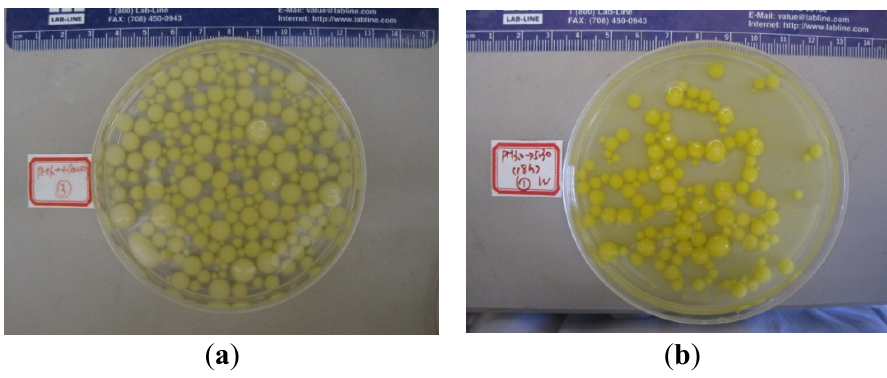
Figure 1. Pelletization of Mucor circinelloides : ( a ) by adding CaCO adjusting pH during cell growth [5].